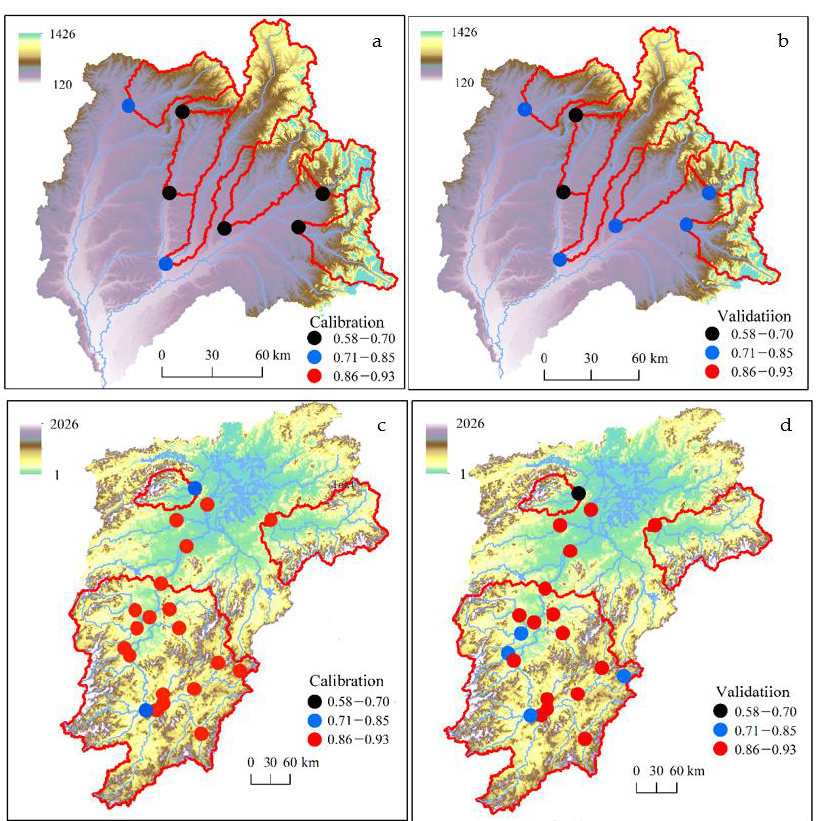
Figure 5. Spatial distributions of the Nash-Sutcliffe Efficiency (NSE) for the hydrological model applied to the Hulan River Basin and Poyang Lake Basin (( a ) calibration period for Hulan River Basin; ( b ) validation period for Hulan River Basin; ( c ) calibration period for Poyang Lake Basin; ( d ) validation period for Poyang Lake Basin).